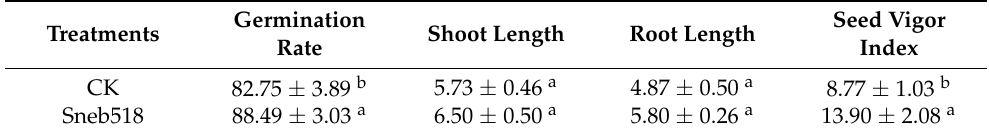
Figure 3. Phylogenetic tree of strain Sneb518 based on the partial nucleotide sequences of 16S rRNA. The tree was constructed using the neighbor-joining method based on a bootstrap analysis of 1000 replicates. Table 3. Effect of Sneb518 on the seedling growth of tomato plants.